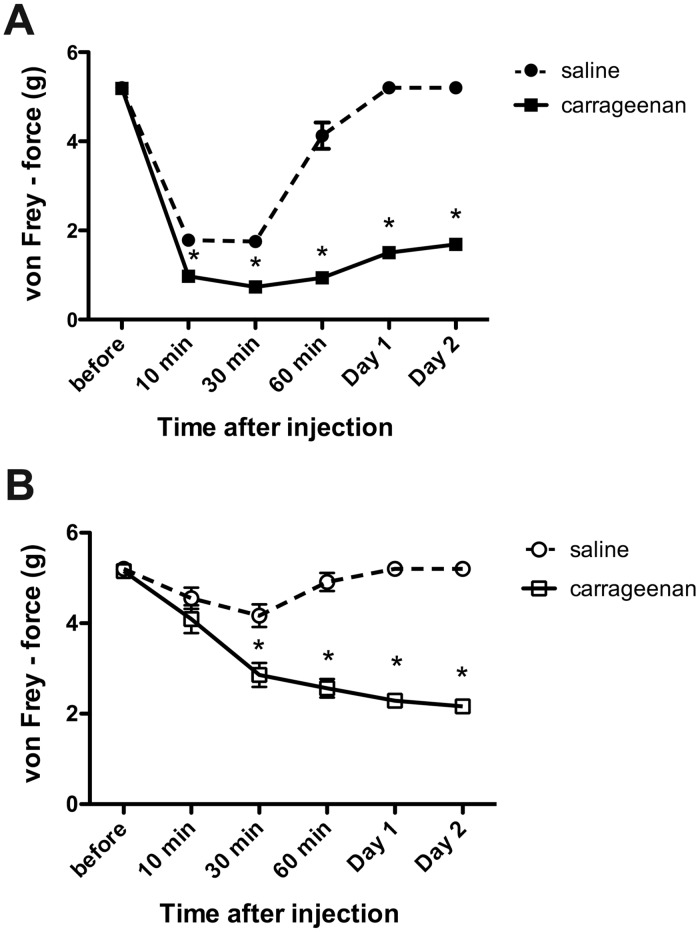
Intraplantar carrageenan injection induces inflammation-mediated mechanical hyperalgesia.Paw withdrawal thresholds (PWT) following saline or carrageenan injection were determined using the von Frey test on the ipsilateral (A) and contralateral sides (B). (n = 25 mice for saline and n = 27 mice for carrageenan). *p < 0.05 compared with the respective saline-treated mice (two-way ANOVA with the Bonferroni post hoc test).